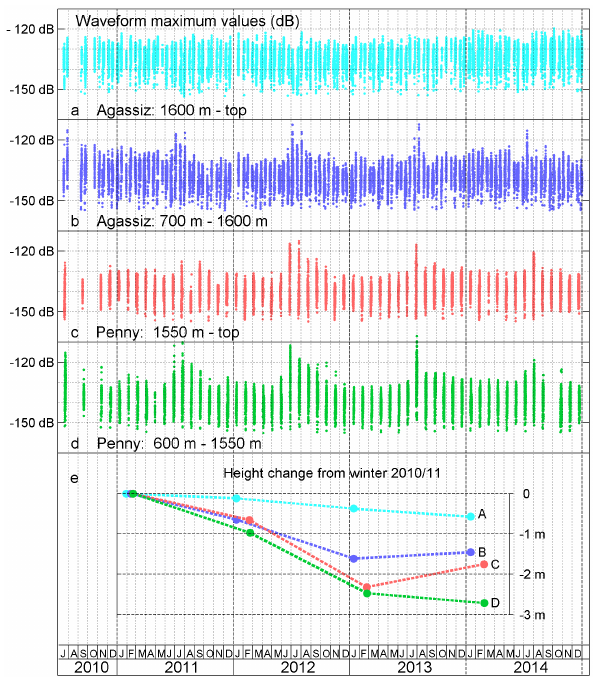
Figure 14. Waveform maxima (a–d) for two elevation ranges of the Agassiz and Penny Ice Caps. The winter-to-winter average height change for the four data groups are shown with the same colours in (e)